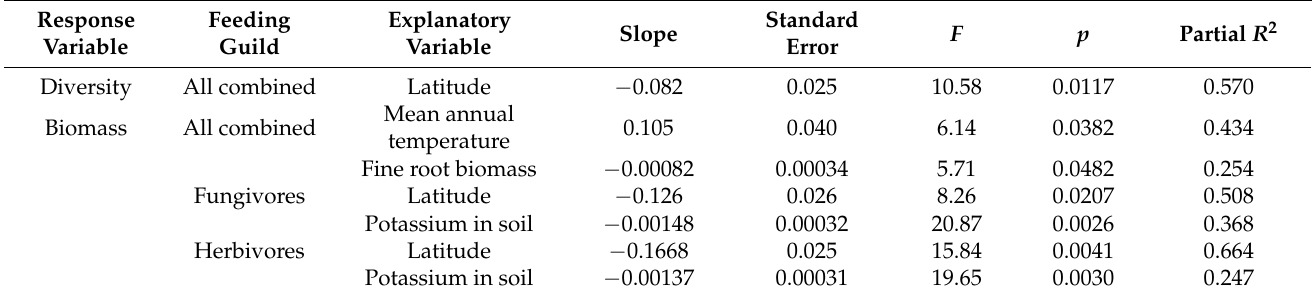
Table 3. Characteristics of the best-fit linear models explaining variation in the diversity (Shannon H index) and biomass of soil macrofauna: the outcomes of the forward stepwise regression analyses. None of the explanatory variables entered the analyses of biomass of detritivores and